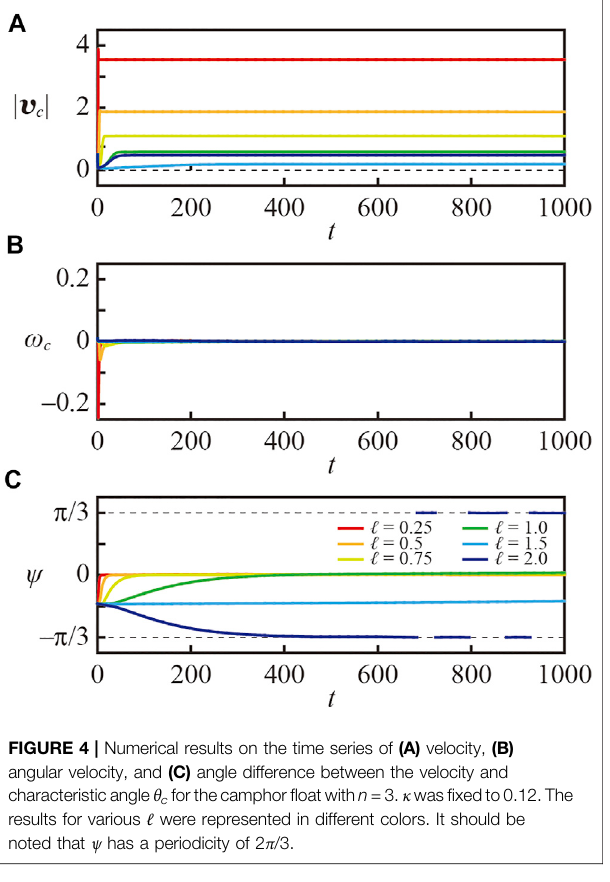
FIGURE 4 | Numerical results on the time series of (A) velocity, (B) angular velocity, and (C) angle difference between the velocity and characteristicangle θ c forthecamphor fl oatwith n =3. κ was fi xedto0.12.The results for various ℓ were represented in different colors. It should be noted that ψ has a periodicity of 2 π /3.